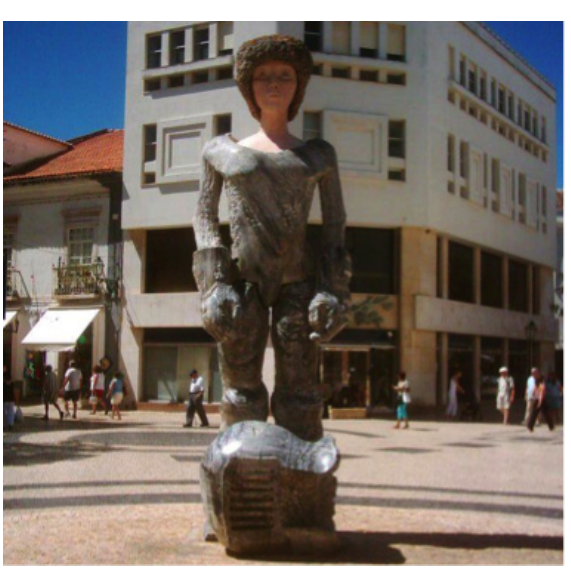
FIGURE 16 | J. Cutileiro, D Sebastião, 1973,